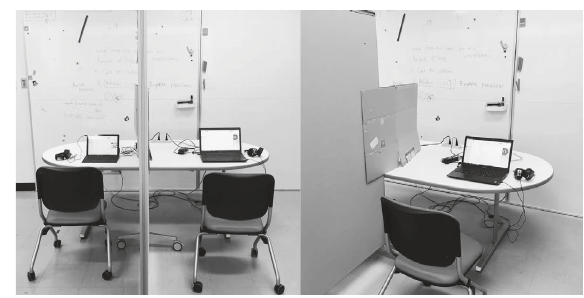
Figure 6: Actual experimental setting.